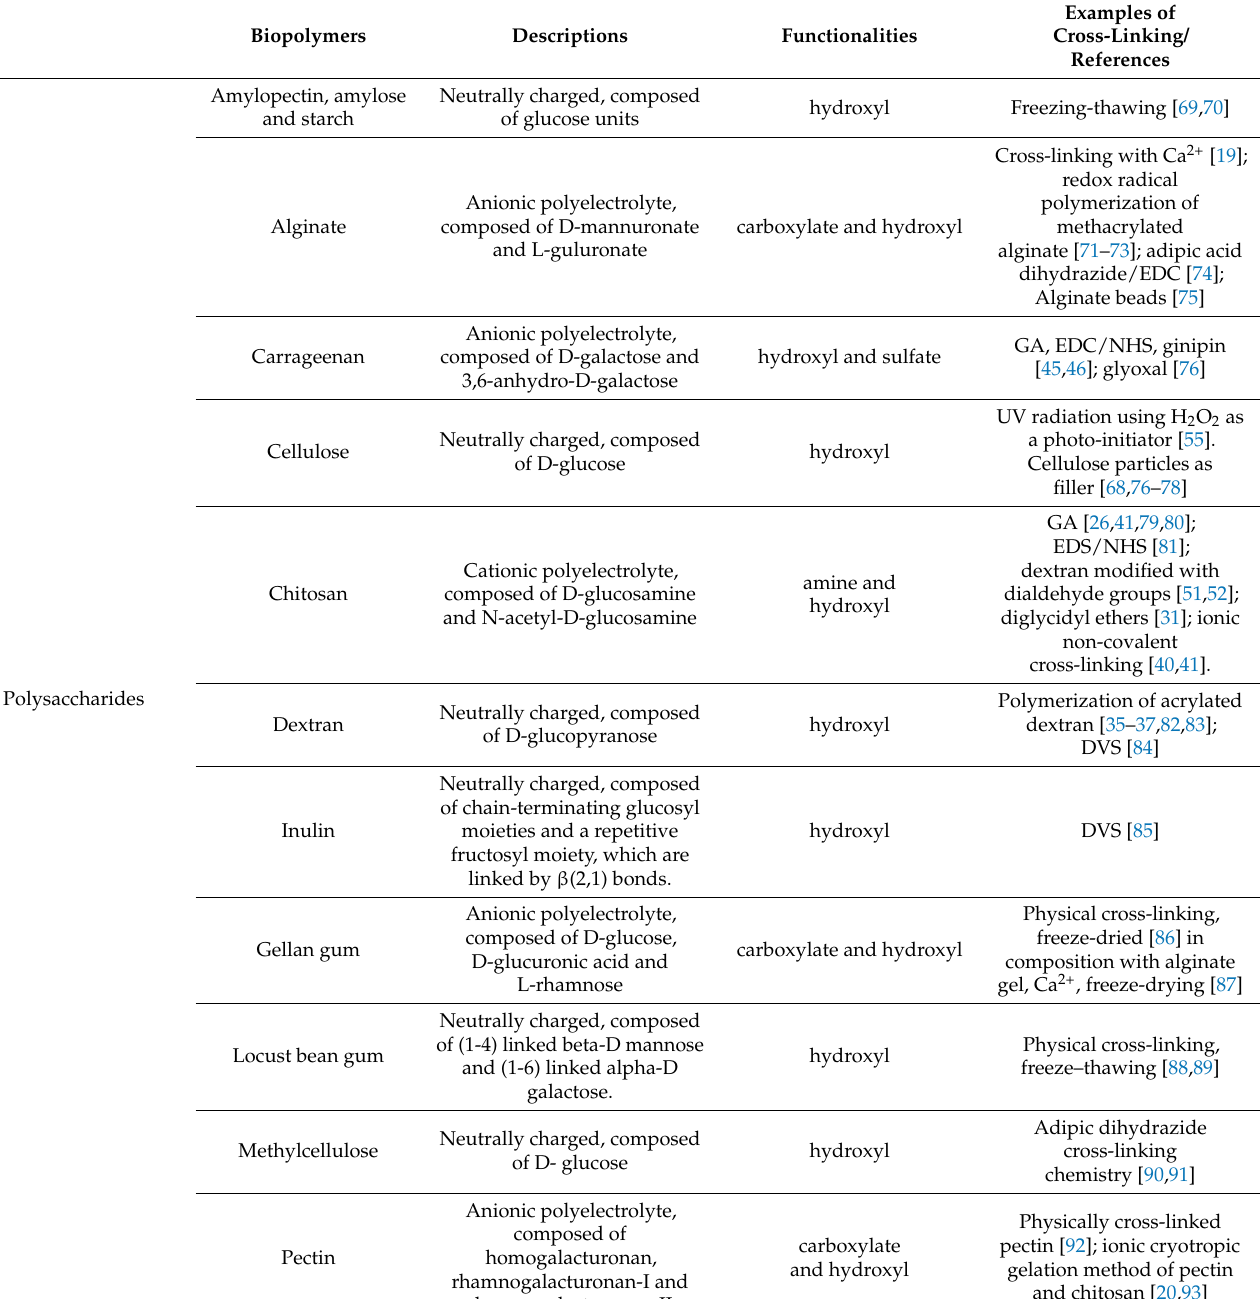
Table 2. Natural polymers used for cryogel